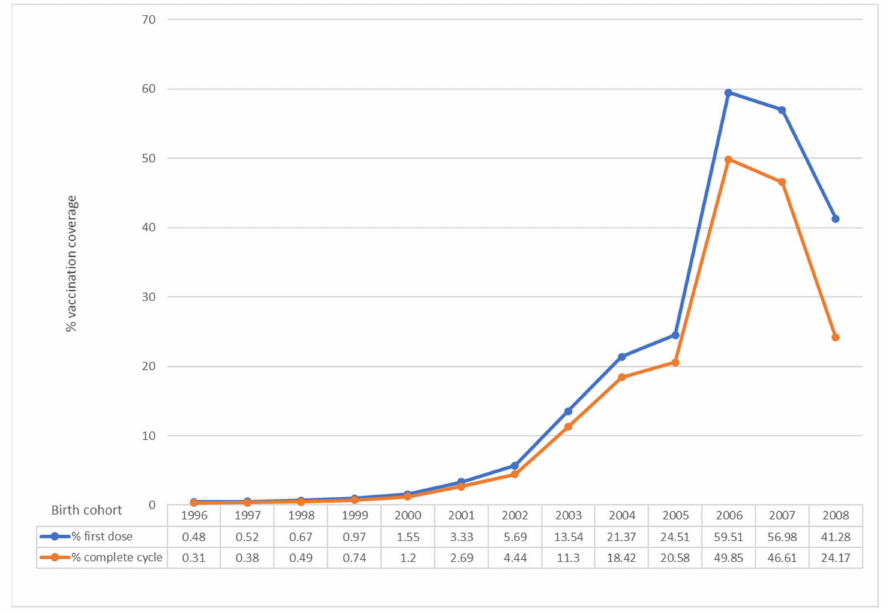
Figure 2. HPV vaccination coverage in Italy, observed year 2020. First dose and complete cycle per birth cohort (males). Data updated to 31 December 2020 (modified by [39]).